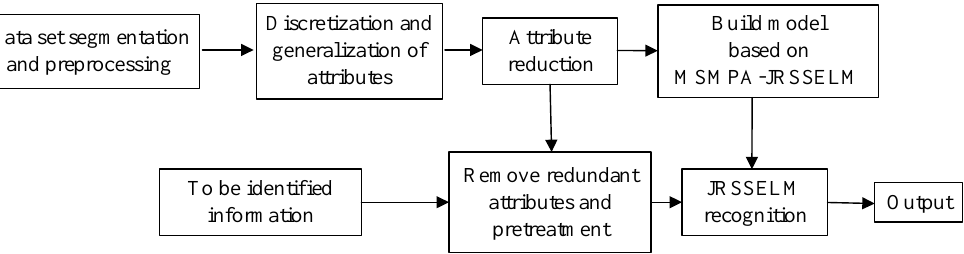
Figure 3. Block diagram of MSMPA-SSELM oil layer identification system. Phase 1 (Data set delineation and pre-processing). The selection of the dataset should